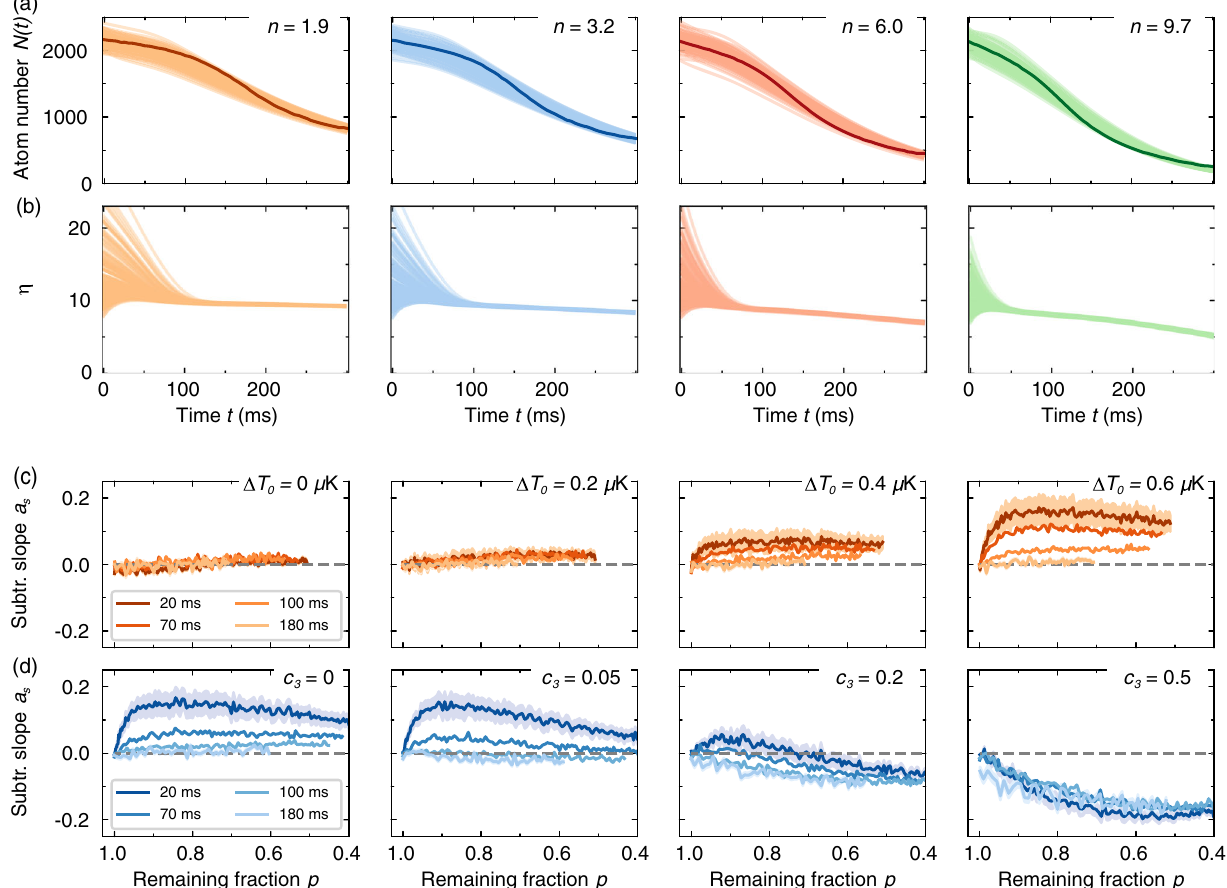
FIG. 8. Theoretical modeling of evaporation. (a) Simulation of atom-number dynamics during forced evaporation for the trap ramp shown in Fig. 7. We show 200 traces with initial atom numbers N 0 and temperatures T 0 sampled from Gaussian distributions in light color, for varying intracavity photon number n as indicated in the top right corner. The atom-number samples have a mean h N 0 i and a standard deviation of 2 h N 0 i 1 = 2 . The temperature distribution is centered about the initial temperature T 0 and has a standard deviation of Δ T ¼ 0 . 6 μ K. We include a three-body loss contribution scaled by c ¼ 0 . 2 . The dark line shows the measured atom-number dynamics 0 3 T , for the same ensemble as in (a). The initially broad including shift correction. (b) Ratio of trap depth to temperature, η ¼ U=k B distribution is rapidly narrowed down and then remains nearly constant during further evaporation. (c) Subtracted slope a for n ¼ 1 . 9 s for different temperature spreads (indicated in the top right corner) in the absence of three-body loss ( c 3 ¼ 0 ). We observe the same trends as observed in our experiment, with a fast rise for small p and a decay with increasing initial time t 1 (indicated in the legend). The shaded region indicates the standard deviation extracted from a bootstrap analysis of the calculated samples. (d) Subtracted slope a for s n ¼ 3 . 2 and Δ T 0 ¼ 0 . 6 μ K for increasing contribution of three-body loss characterized by the scaling factor c 3 (indicated in the top right corner). Three-body loss leads to a negative contribution to a , which suppresses the effect of initial temperature s